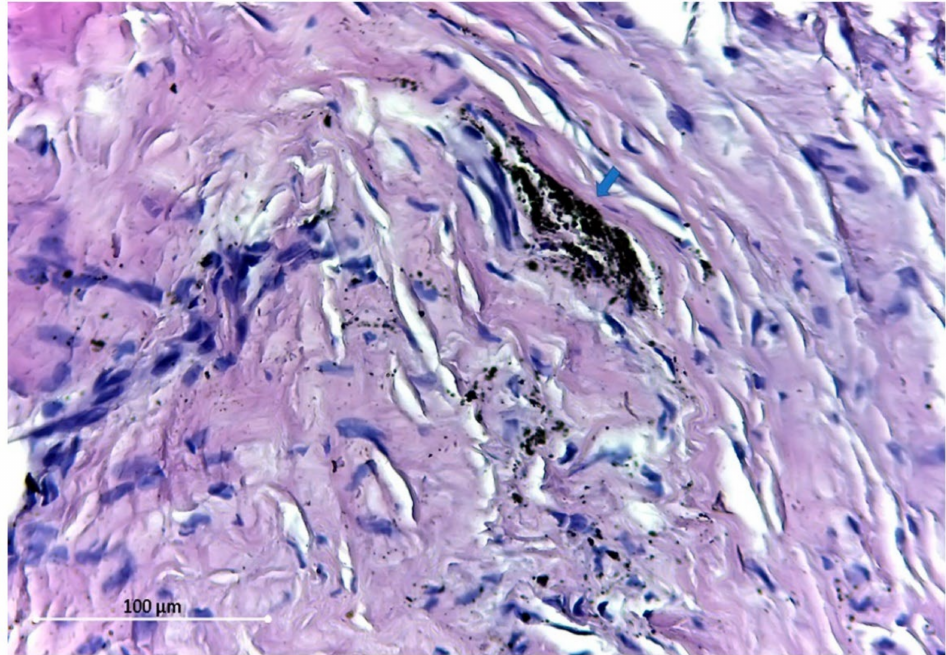
Figure 4. HE-section of a soft tissue biopsy surrounding commercially pure titanium plates after mandibular osteosynthesis under LM. Dust-like (1 micron) particles are indicated with a blue arrow (magnification × 400). HE, hematoxylin and eosin; LM, light microscopy. Reprinted with permission from